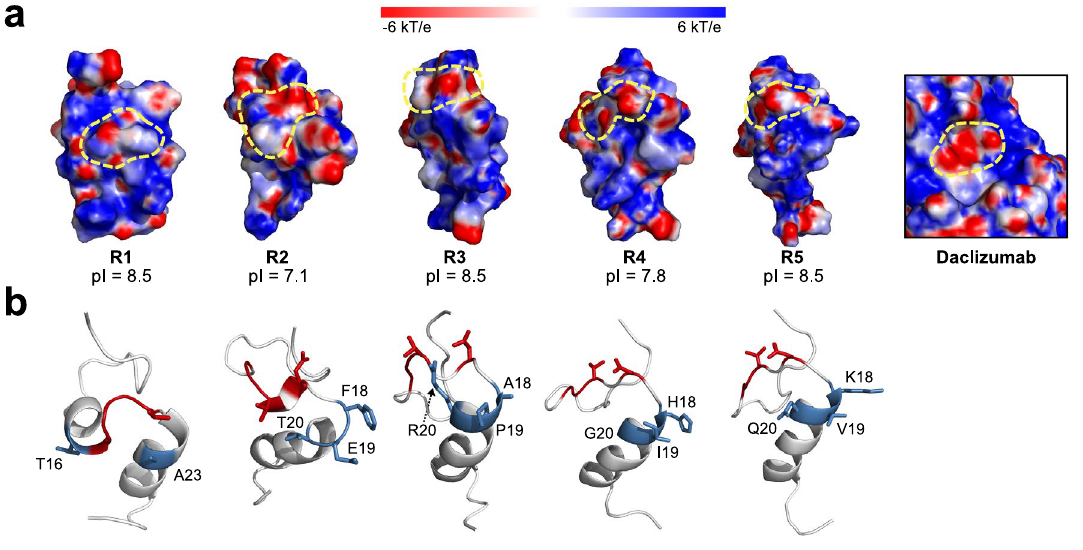
Figure 6. Structural analysis of Zif-R1–R5. ( a ) Electrostatic potential surfaces of Zif-R1–R5 (R1–R5) and daclizumab at pH 7.5. pI values are shown below. Dotted yellow lines indicate the location of daclizumab- derived CDR residues in each peptide. ( b ) Structures of Zif-R1–R5. Mutated residues are shown in the stick representation with daclizumab-derived residues in red and fully randomized residues in blue. Fully randomized residues are labeled in accordance with their